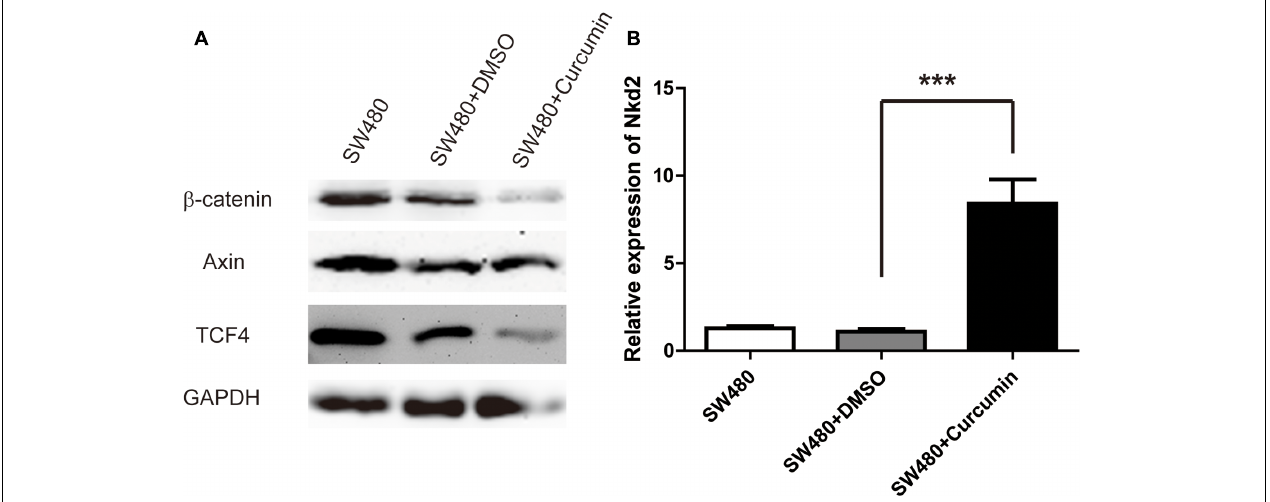
FIGURE 3 | Curcumin inhibited Wnt/ β -catenin pathways. (A) Western blot analysis of the protein expression of β -catenin, axin, TCF4, and GAPDH in SW480 cells following curcumin treatment for 24 h. The concentrations of curcumin was 40 µ M. n = 3 independent experiments and this panel presented one of these repeats. (B) RT-q-PCR of the mRNA level of Nkd2 in SW480 cells with the treatments as indicated. Data were represented as mean ± SD; n = 3 independent experiments. ∗∗∗ p < 0.001.